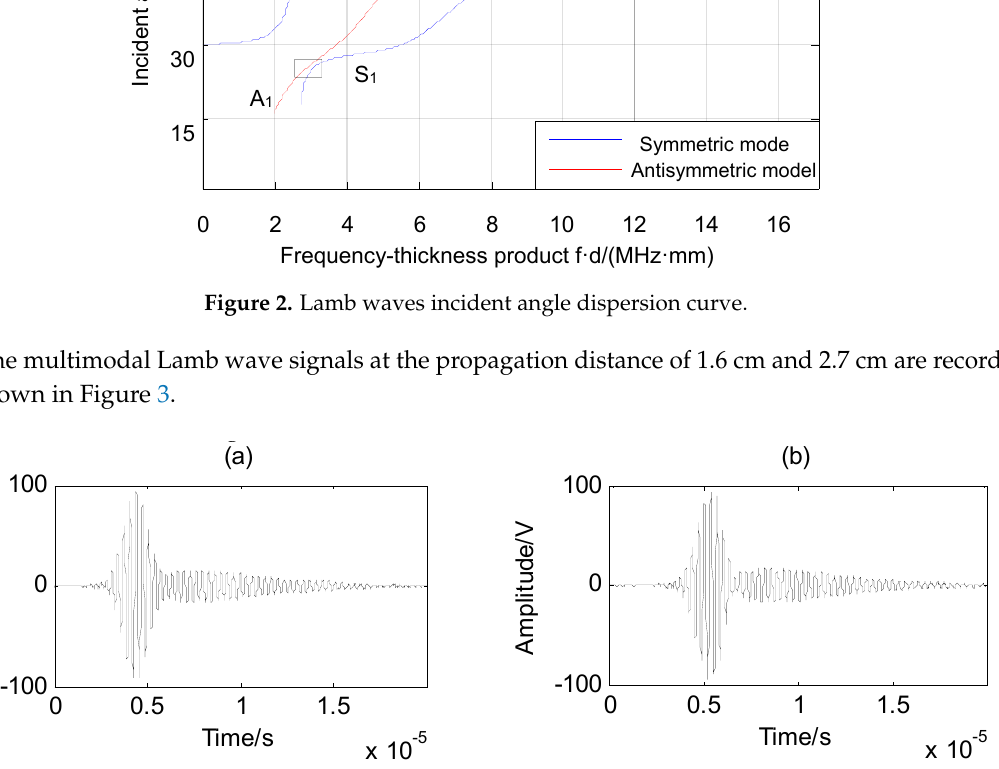
Figure 3. Multimodal Lamb wave signals at the propagation distance of ( a ) 1.6 cm and ( b ) 2.7 cm.